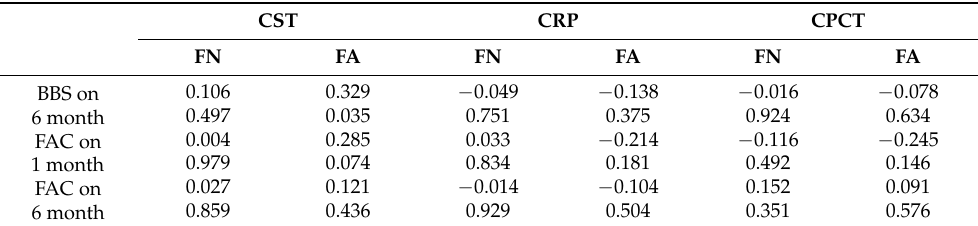
Table 5. Correlation of DTI parameters and functional assessment scores on 1 month and 6 months after the stroke